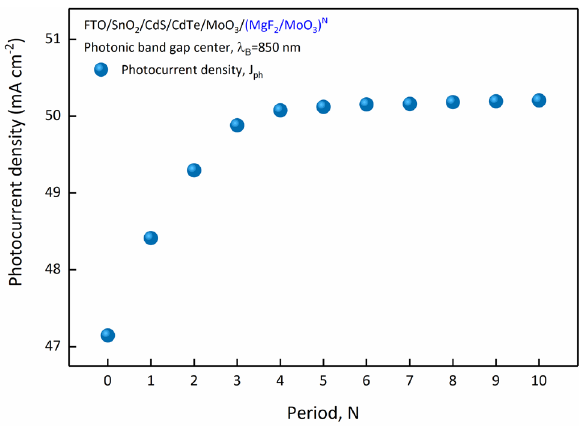
Figure 5. Variation of J ph according to the number of periods in FTO/SnO 2 /CdS/CdTe/MoO 3 /(MgF 2 /MoO 3 ) N SC.